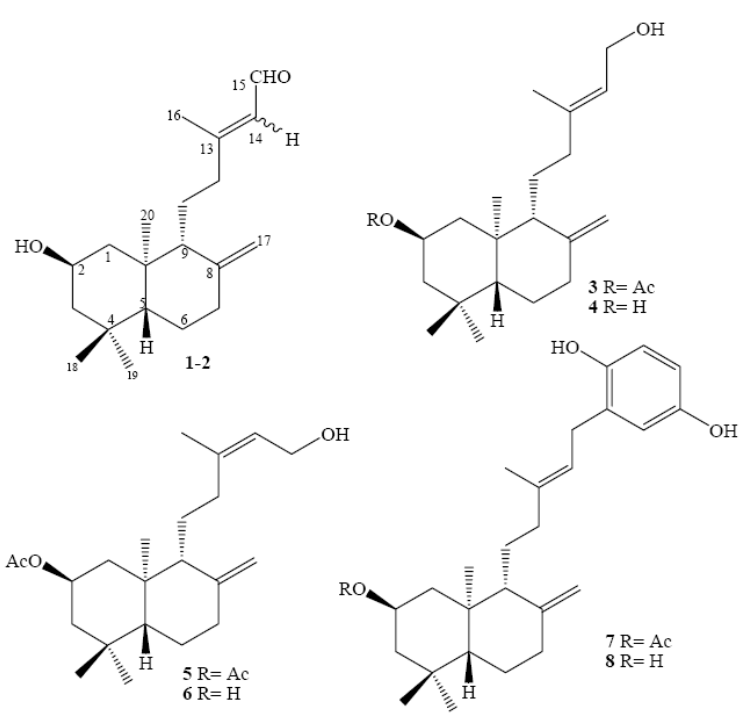
Figure 2. Series of natural ent -labdanes derivatives.